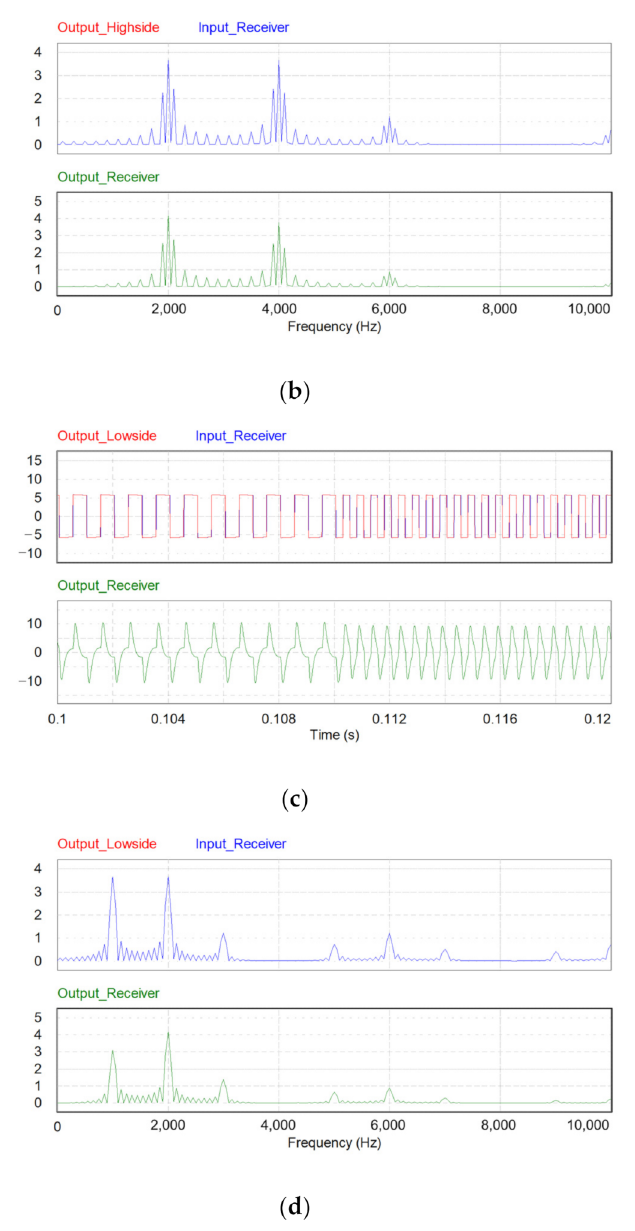
Figure 18. Transmitter/receiver response characteristics (disconnection state): ( a ) high side frequency characteristics; ( b ) high side FFT characteristics; ( c ) low side frequency characteristics; ( d ) low side FFT